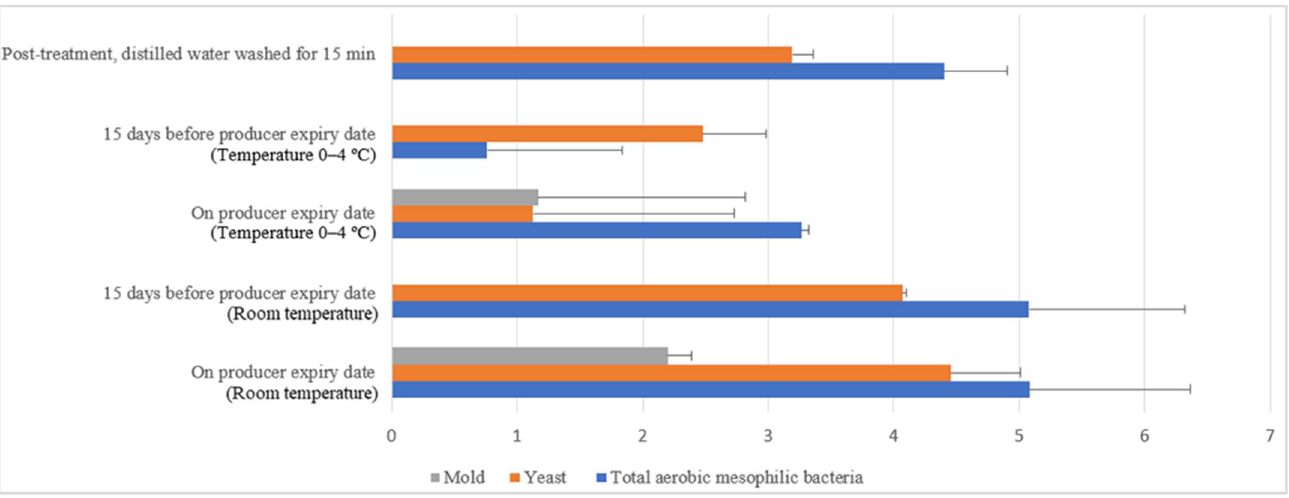
Figure 14. Microbial load (log10 CFU/cm 2 ) during storage at room and chill temperature washed with distilled water.